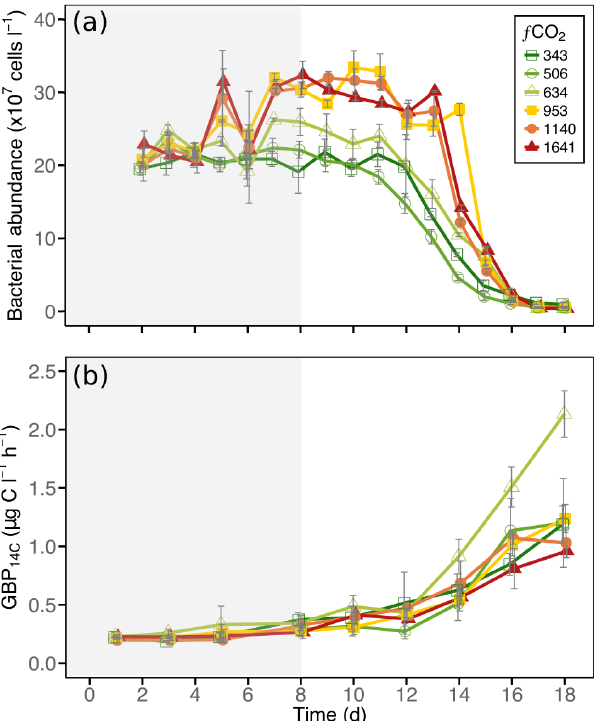
Figure 9. Bacterial abundance and community production in each of the minicosm treatments over time. (a) Bacterial cell abundance and (b) 14 C-derived gross bacterial production (GBP 14 bars display 1 standard deviation of pseudoreplicate samples. Grey shading indicates CO 2 and light acclimation